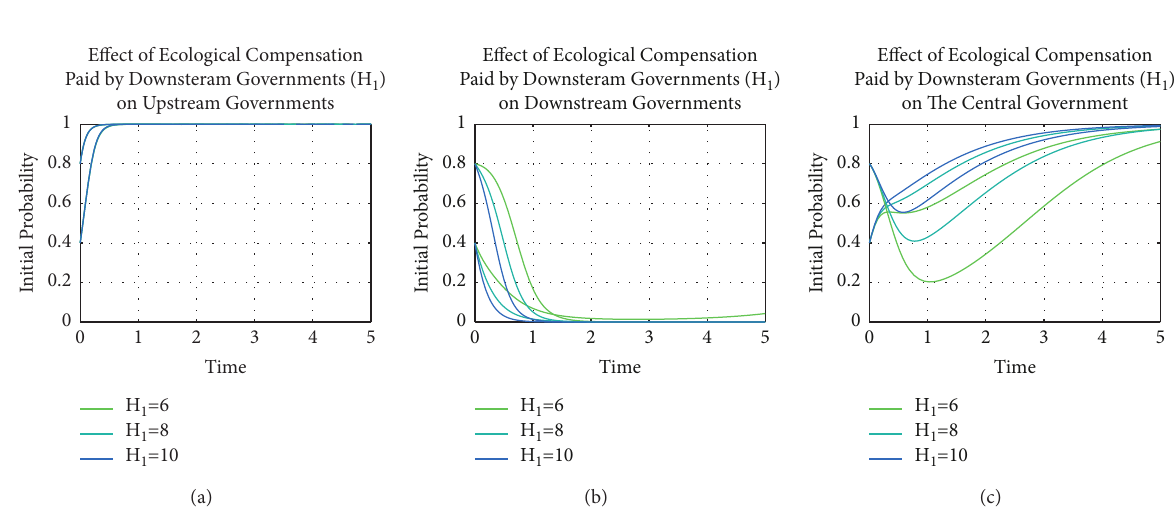
Figure 6: The effect of ecological compensation paid by downstream governments ( H pensation paid by downstream governments ( H 1 ) on upstream governments. (b) Effect of ecological compensation paid by downstream governments ( H 1 ) on downstream governments. (c) Effect of ecological compensation paid by downstream governments ( H 1 ) on the central government.